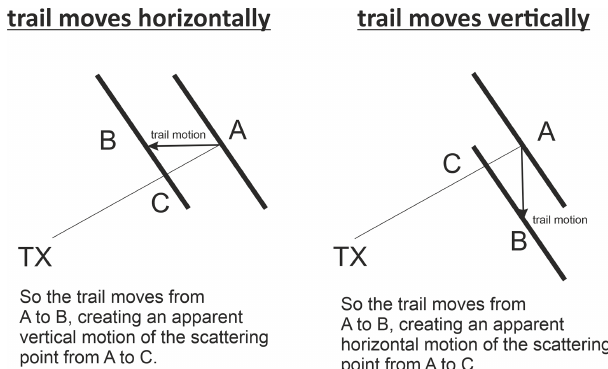
Figure 2. Idealized schemes of the specular scattering geometry in- dicating the apparent motion of the specular point or scattering cen- ter along the trail due to the drift of the meteor plasma column by neutral winds. The length of the meteoric trails is several kilome- ters, whereas the apparent motions of the scattering center are of the order of the meteor. The label ”A” shows the position of the specular point at the first detection, “B” denotes the location of the scattering center assuming it stays glued to the same mid-point of the trail, and “C” shows the position of the reflection point sustain- ing the transmitter and receiver